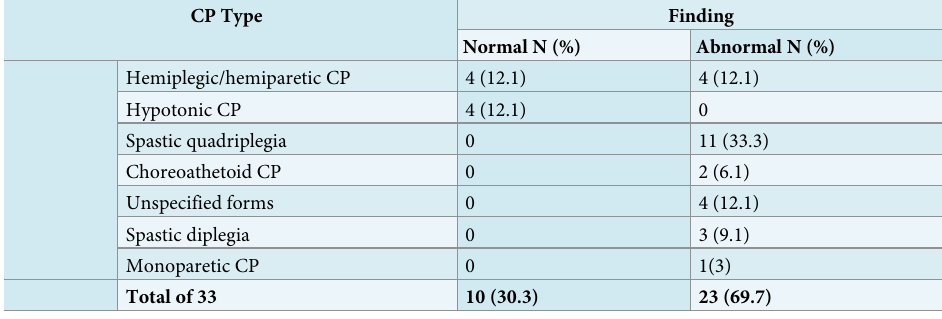
Table 3. Patterns of neuroimaging findings based on type of CP from January 2016 to August 2019.